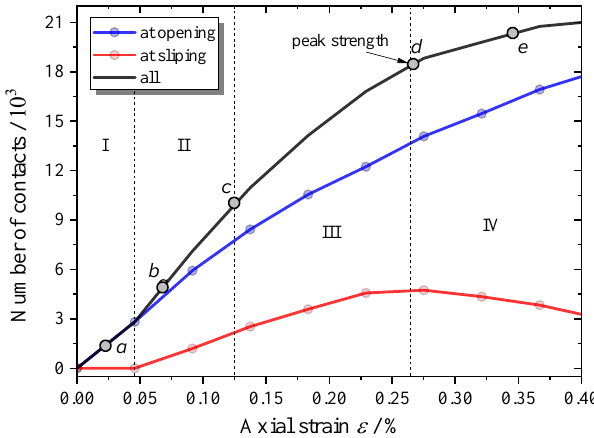
Figure 11. Microcrack evolution during the complete failure process.